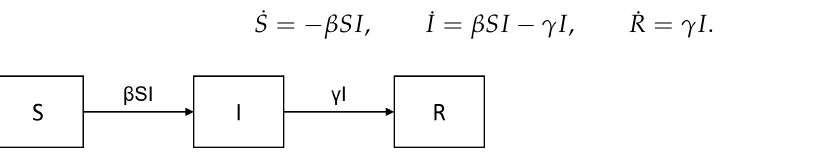
Figure 1. Flow diagram of the SIR